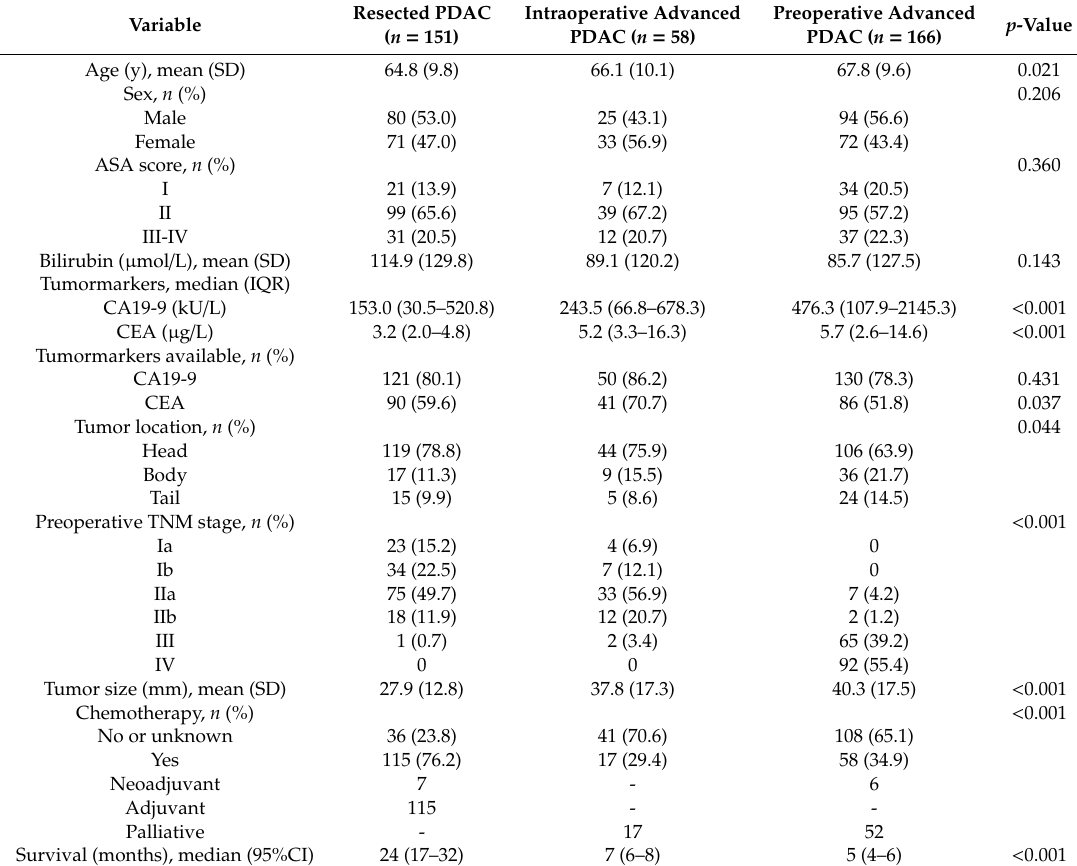
Table 1. Patient and tumor